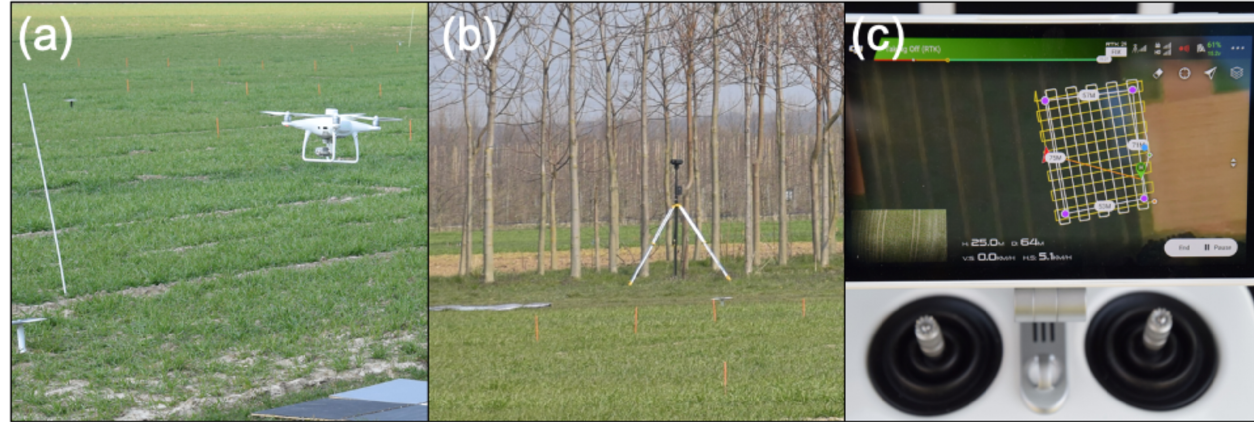
Figure 3. The utilized UAV for crop height analysis is ( a ) a DJI© Phantom 4 RTK, which can be operated in RTK mode using ( b ) a base station. Flight planning is also possible ( c